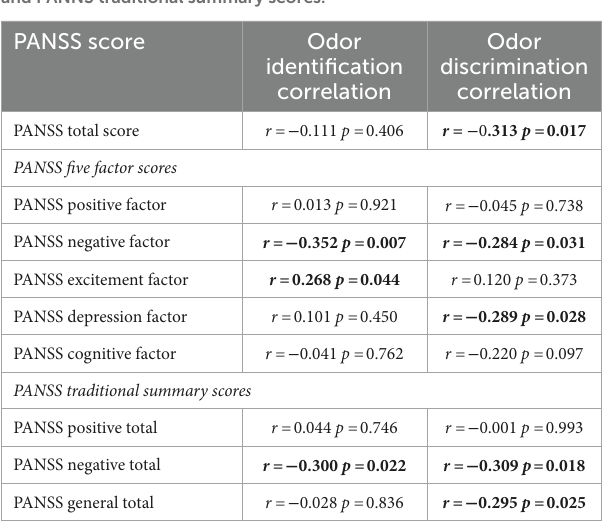
r = Pearson correlation coefficient. a Represents the significance of additional effect of sex on the correlation with the cognitive variable in females compared to the cognitive variable in males. Statistic derived from multiple regression analysis to assess the sex effect in schizophrenia patients. Bolded values are statistically significant F at P < 0.05. TABLE 7 Relationship of odor identification and discrimination to PANSS scores in patients with chronic schizophrenia, PANSS five factor analysis, and PANNS traditional summary